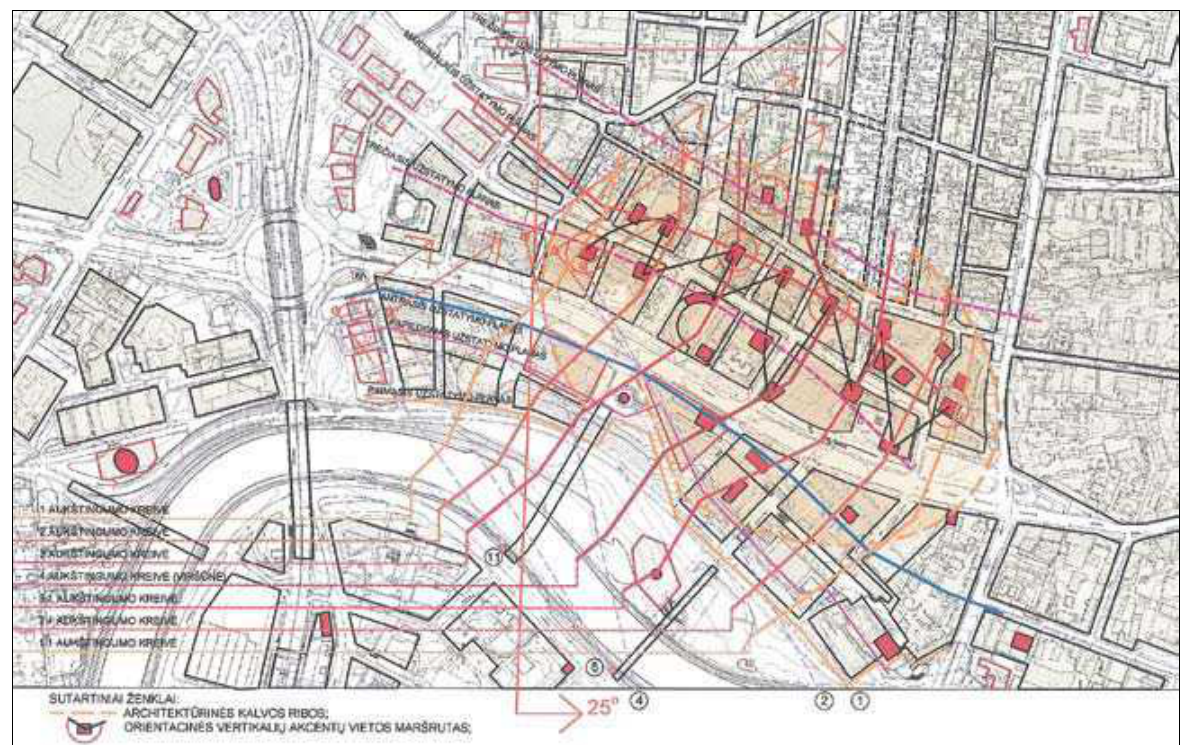
Fig. 7. height layers of urban landscape